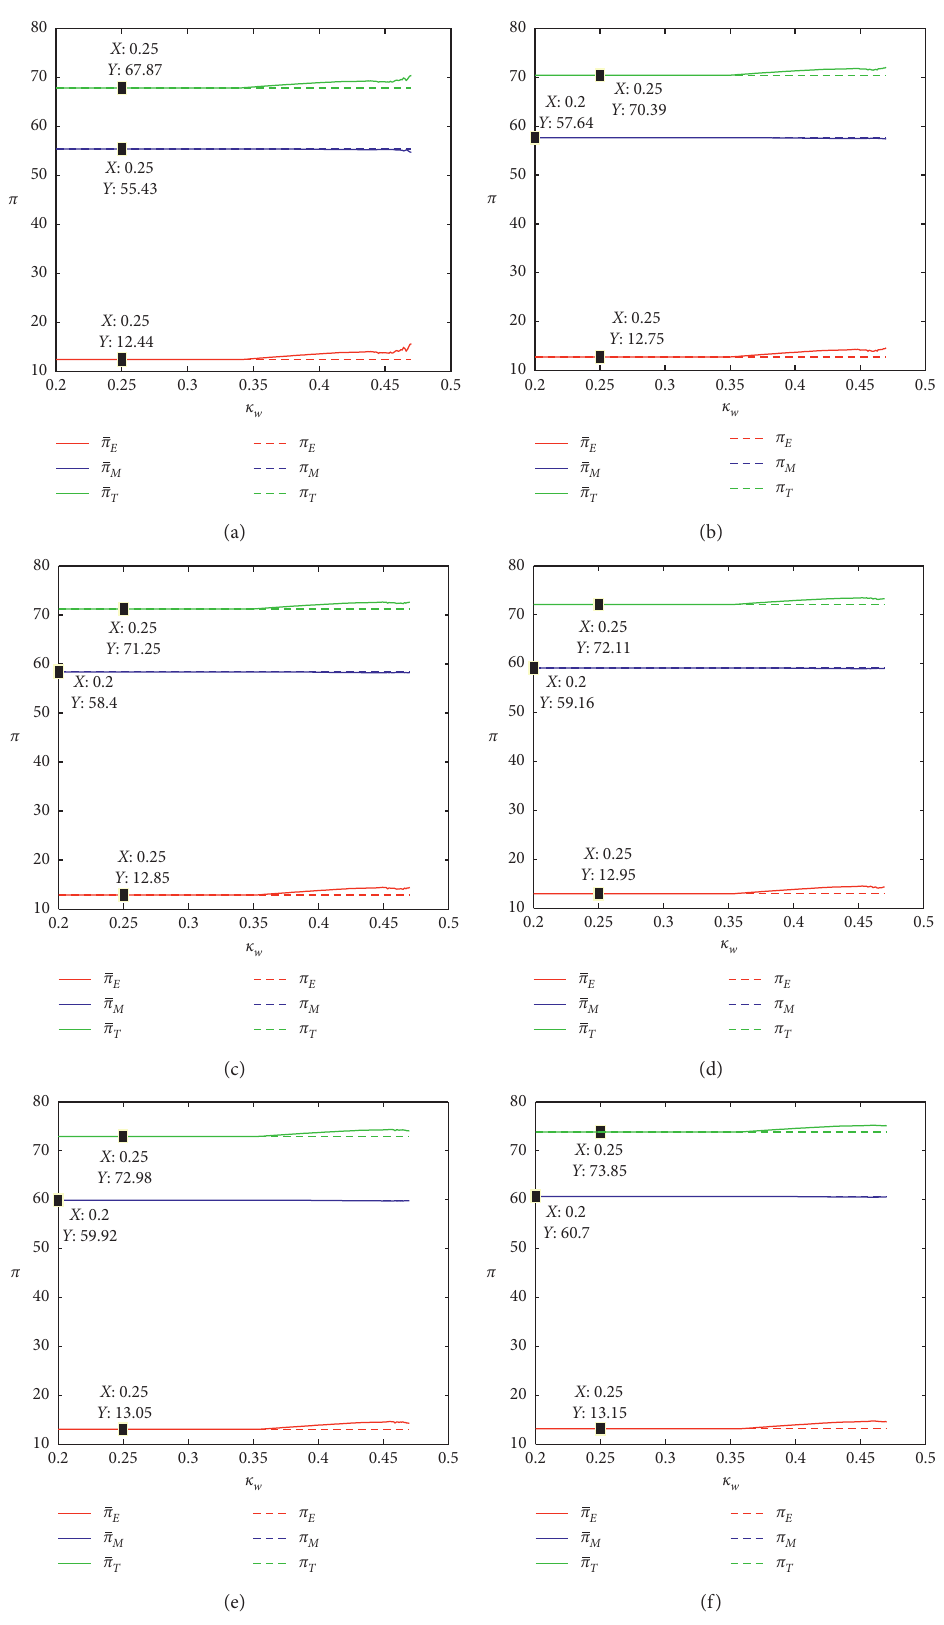
Figure 9: Supply chain members’ average profits via κ (f) τ � 0 .